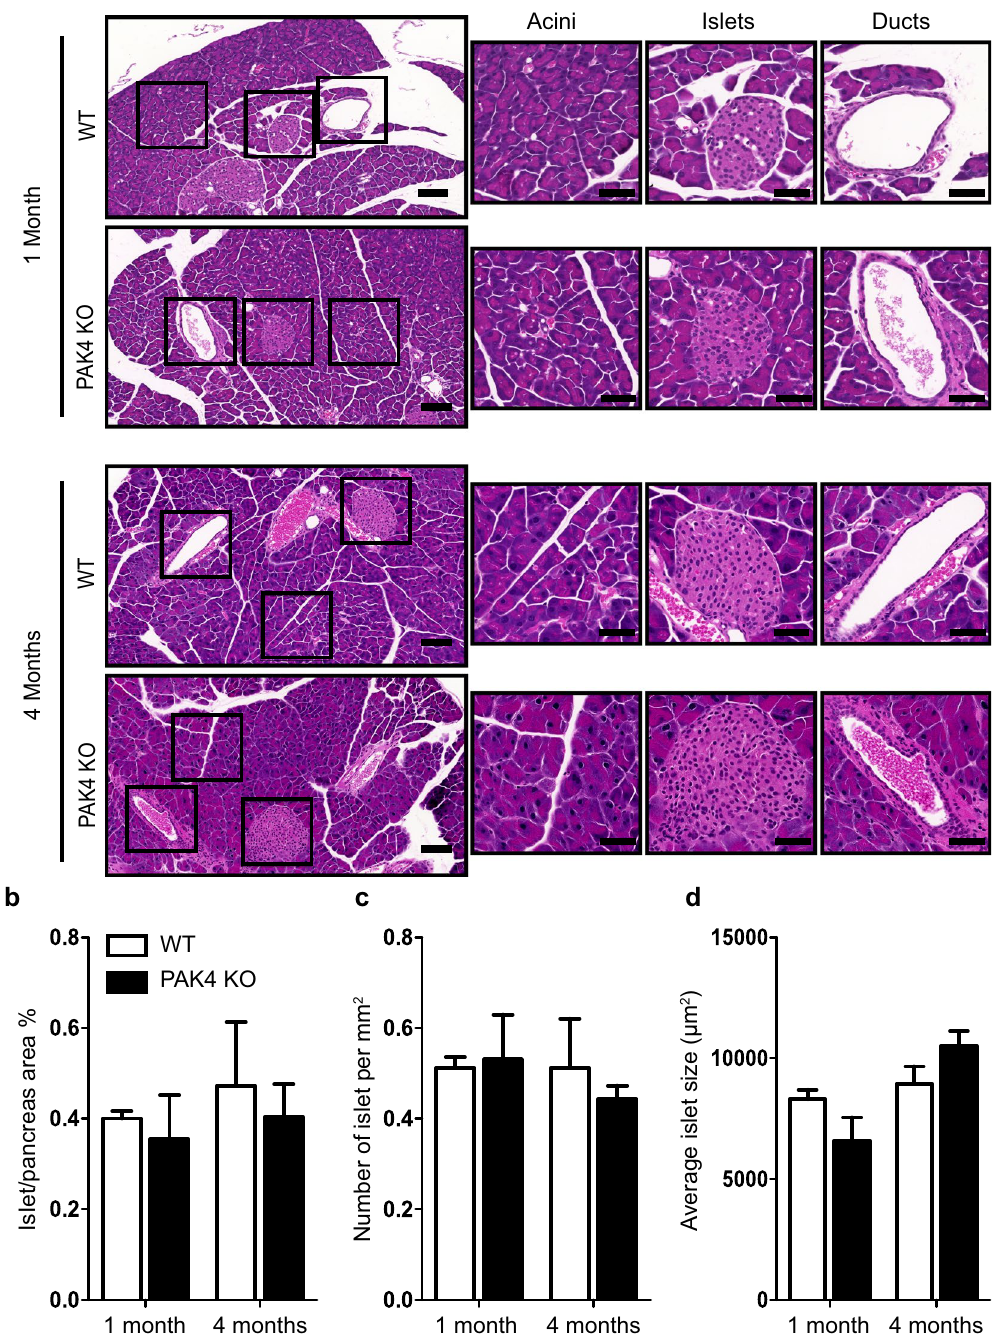
Figure 2. Histomorphology of pancreatic tissue upon conditional PAK4 KO resembles that of WT. ( a ) Representative images of pancreatic sections of WT and PAK4 KO mice of one and four months of age stained with hematoxylin and eosin (H&E). Acini, islets and ducts developed normally in both genotypes. Marked boxes in the left are displayed at higher resolution to the right. Scale bars: 100 μ m in the overview image and 50 μ m in the inserts ( b , c , d ) Morphometric data of the H&E-stained pancreatic sections. ( b ) The bars display the percentage of islet area per pancreas, 1 month (p = 0.6046, n = 3–4) and 4 months (p = 0.6527, n = 3–4). ( c ) The number of islets per square millimeter of pancreatic area, 1 month (p = 0.8290, n = 3–4) and 4 months (p = 0.5092, n = 3–4). ( d ) Average islet size. 1 month (p = 0.1205, n = 3–4) and 4 months (p = 0.1573, n = 3–4). Data are expressed as the mean ± SEM. T-test revealed no discernable differences between the